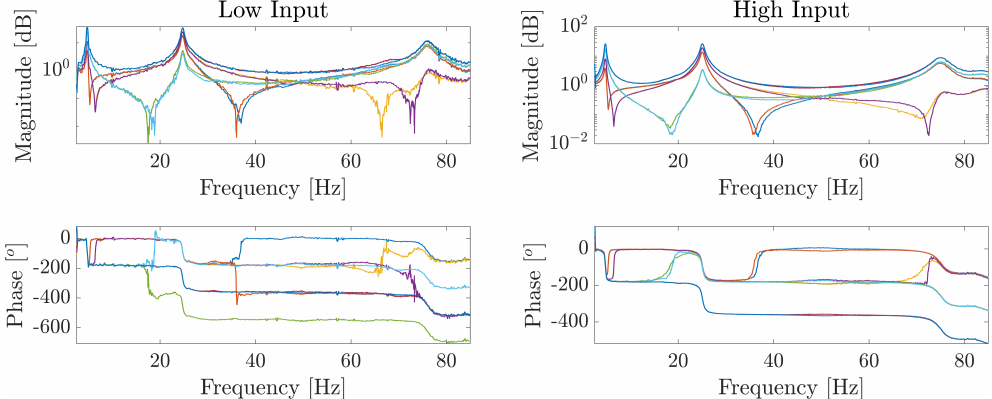
Figure 8. Twin spar: FRFs of the low and high input scenarios. All channels are superimposed for